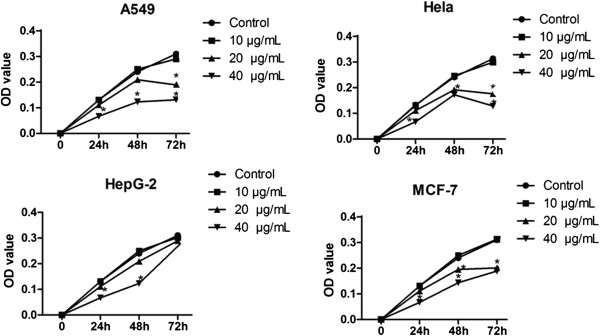
Grailsine-Al-glycoside inhibited the proliferation of A549, MCF-7, HepG2, and Hela cells. Cells were seeded in 96-well plates and treated with different concentration of Grailsine-Al-glycoside for up to 72 hr. Every 24 hr, a group of six wells from each treatment were subjected to MTT to analyze cell proliferation.